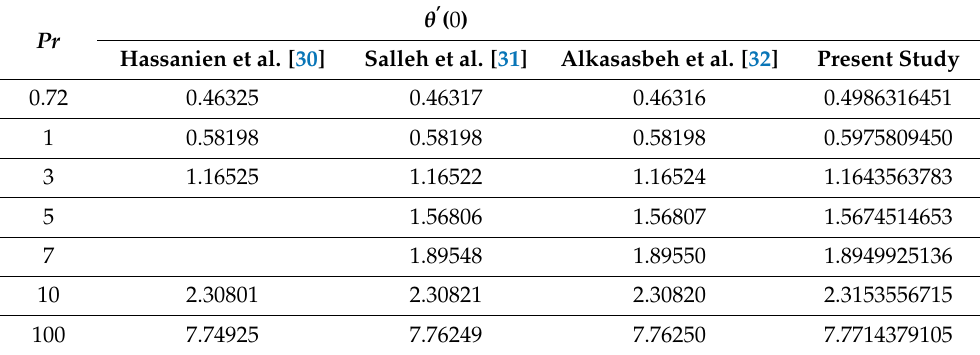
Table 3. Comparison of the θ (cid:48) ( 0 ) when ξ = 0.1 and F r = M = G r = Ec = Q = Rd = 0 with published literature Refs. [30–32].